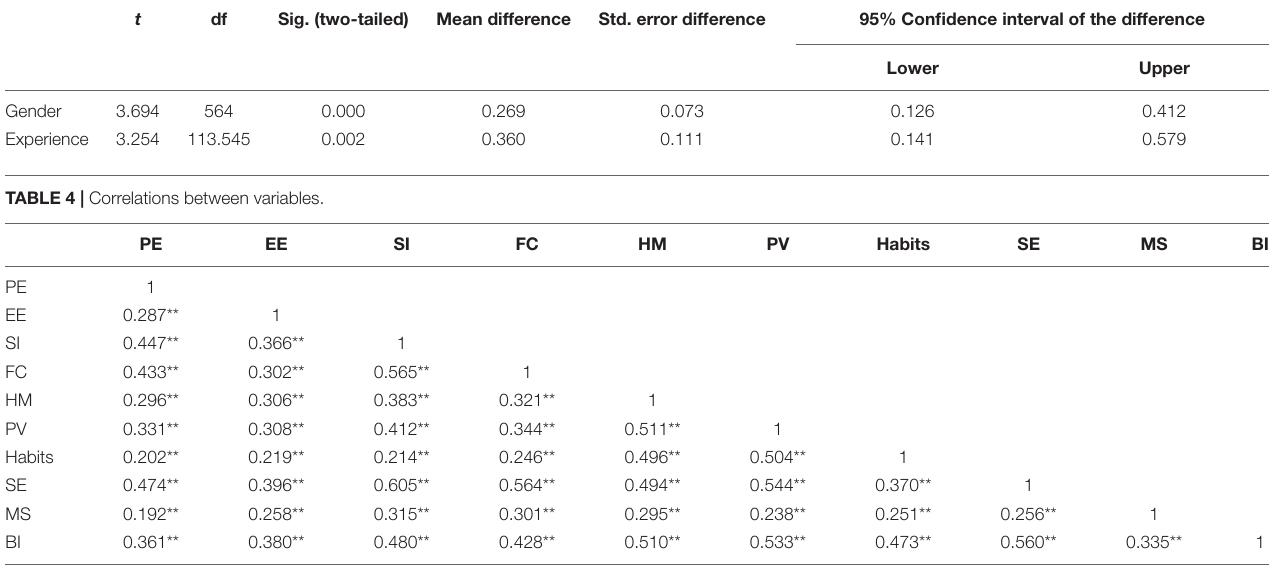
TABLE 3 | Independent samples t -test on BI for gender and experience.